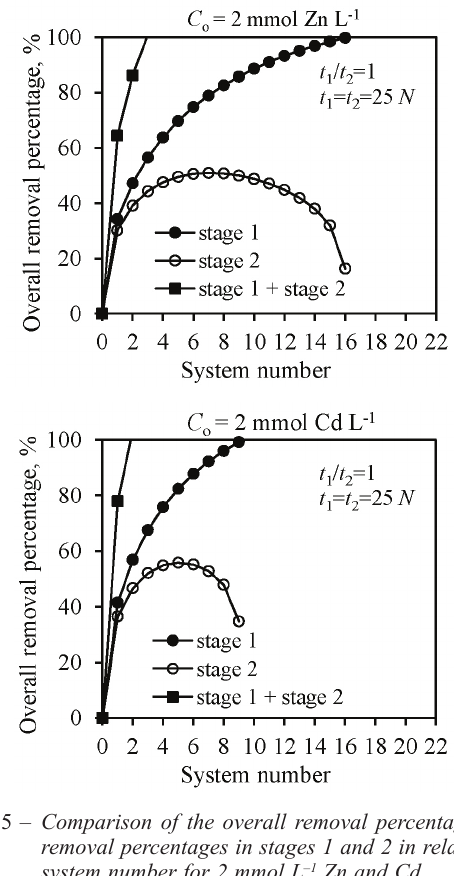
Fig. 4 – Comparison of the overall removal percentage and removal percentages in stages 1 and 2 in relation to system number for 4 mmol L –1 Zn and Cd